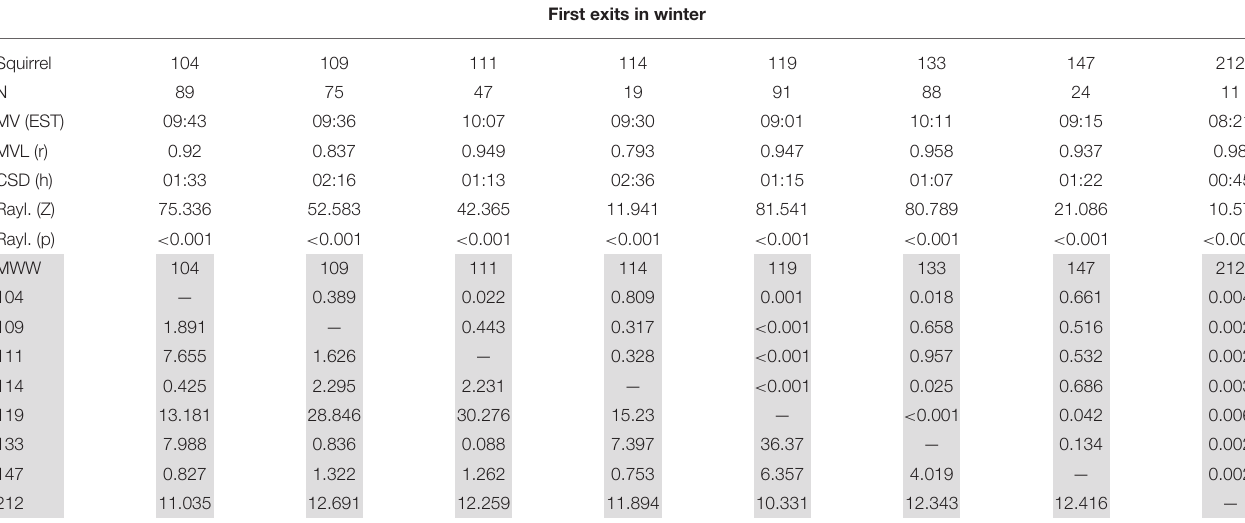
The upper unshaded part describes the circular distribution of first exits for each squirrel, whereas the shaded lower area shows the results of pairwise Mardia–Watson–Wheeler tests (MWW). The upper part provides the significance levels—the lower values are the W scores of the tests. EST, Eastern Standard Time; CSD, circular standard deviation.